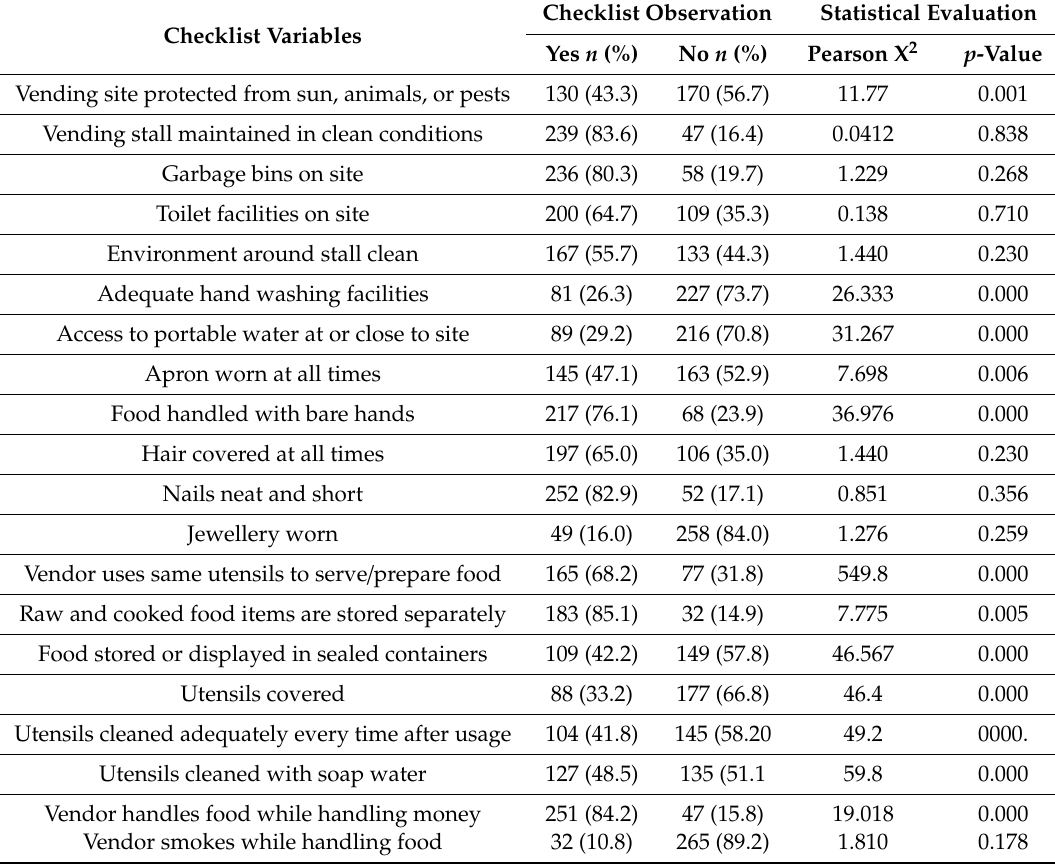
Table 4. Association between cooked food, vending environment and observed food handling